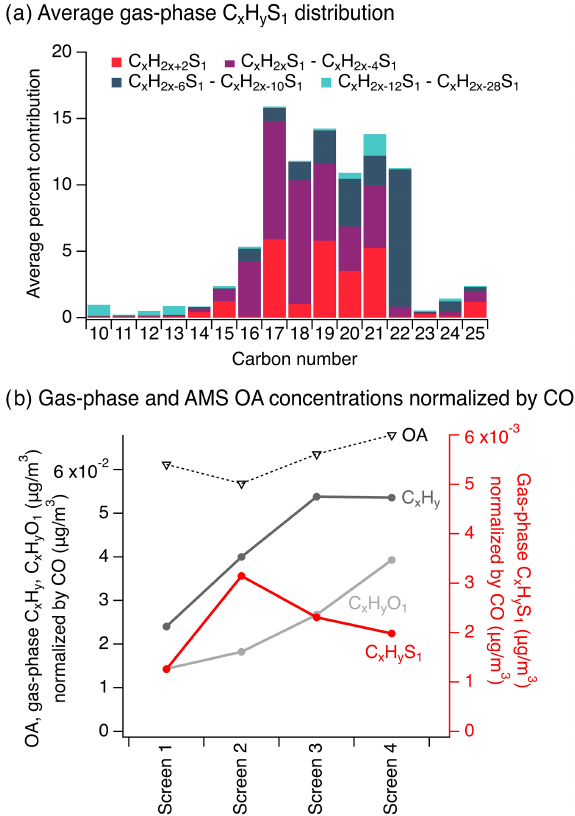
Figure 4. (a) The average C x H y S 1 distribution from targeted GC- APCI-MS across all gas-phase adsorbent tube samples from screens 1–4 (see Fig. S10 for individual C x H y S 1 screens and Fig. S13 for C x H y ) . (b) Concentrations of gas-phase C x H y , C x H y O 1 , and C x H y S 1 from targeted GC-APCI-MS analysis of adsorbent tubes, shown with total OA from AMS, all corrected for dilution using carbon monoxide measurements (see Fig. S12a for non-normalized concentrations). Data in (b) are averaged over low- and high- altitude adsorbent tube